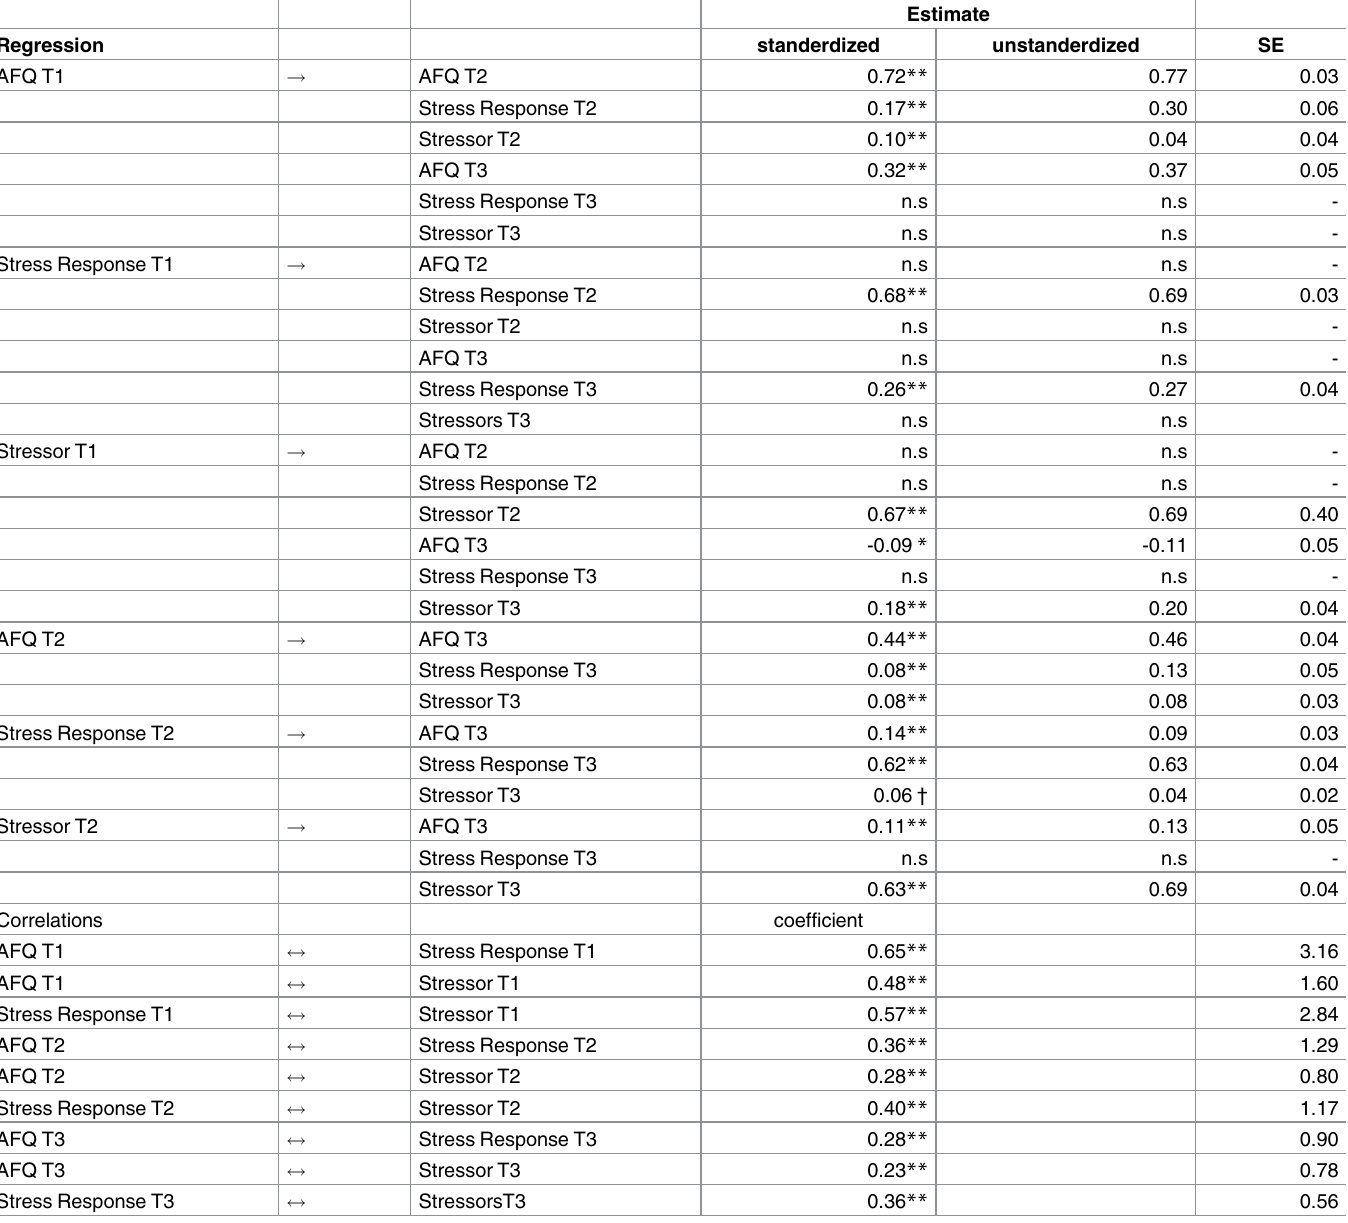
Table 2. Parameterestimatesfor the final cross-lagged